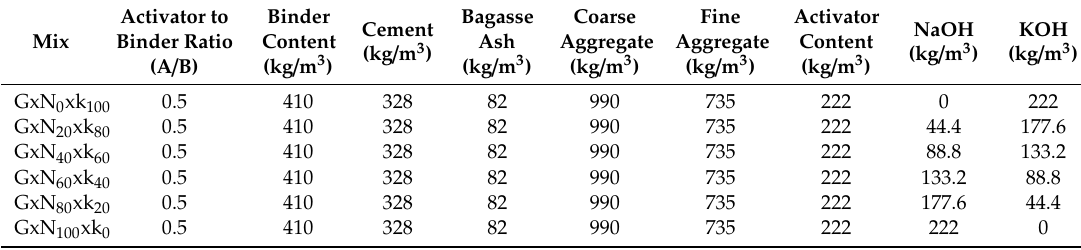
Table 4. Mix design of geopolymer